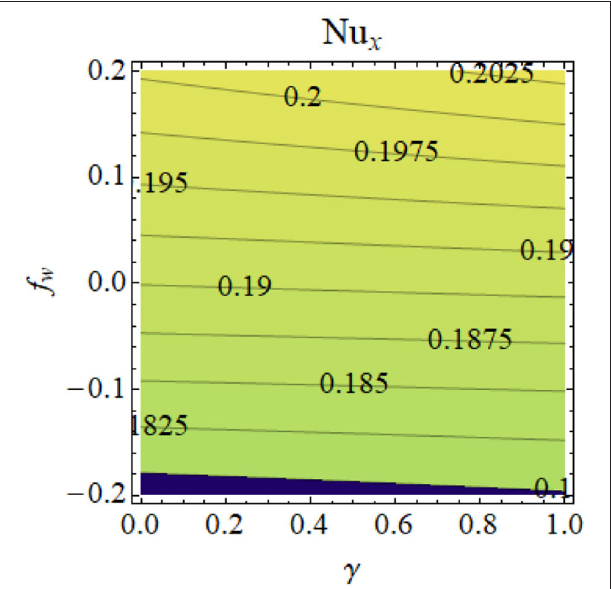
FIGURE 8 | Effects of γ and f w on Nu x